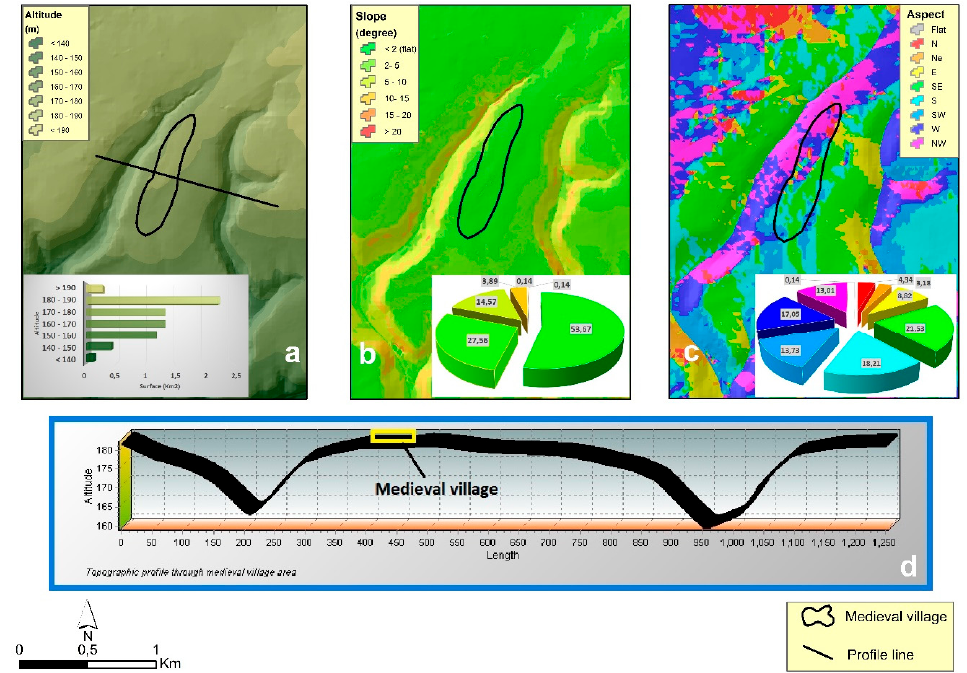
Figure 4. Morphometric parameters of the “S ant ul Turcilor” site: ( a ) hypsometry (altitude); ( b ) slope; ( c ) aspect; ( d ) topographic profile. The geographical parameters were derived using a Lidar DEM (digital elevation model, 1 m resolution) provided by the Banat Waters Administration (ABA